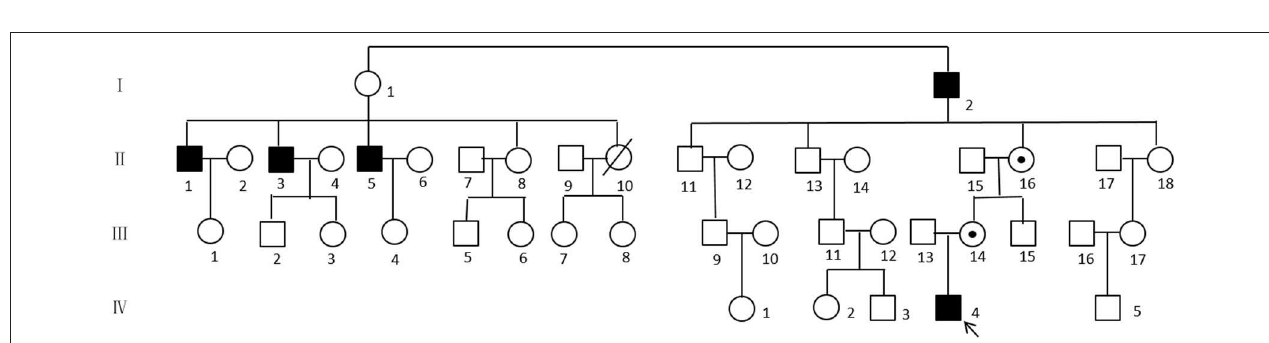
FIGURE 2 | Pedigree of SMAX2 family. Affected males are indicated by black squares and circles are females. Crossed symbols are deceased members. The proband is indicated by the